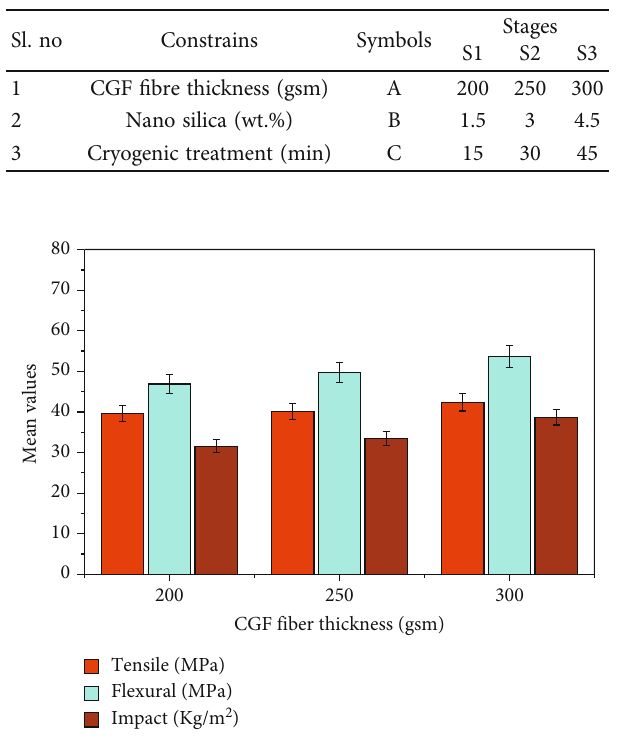
Figure 2: Mean values of tension, bending, and impact strength of hybrid composites based on CGF fi bre